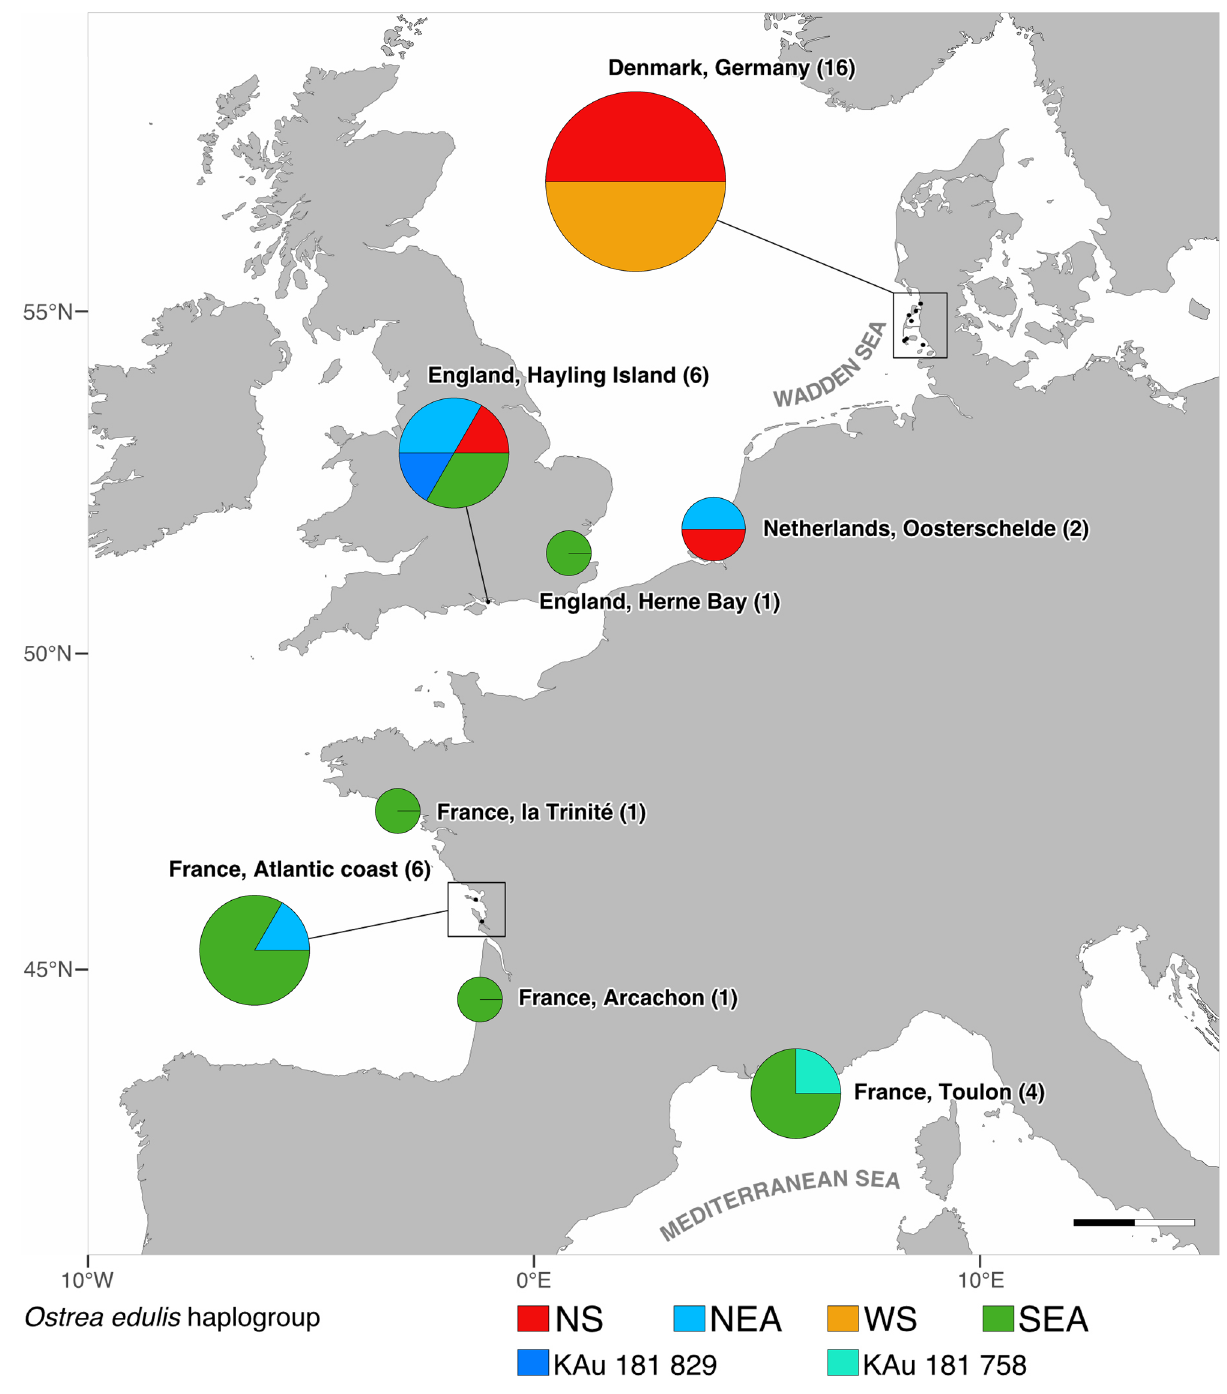
Figure 3. Geographic distribution of mitochondrial haplogroup frequencies of Ostrea edulis in Europe between 1869 and 1879. The smallest pie chart represents a single individual. All sample sizes are given in brackets on each location. Scale bar = 100 km. legend: NS = North Sea, NEA = North East Atlantic, WS = Wadden Sea, SEA = South East Atlantic. Map was created using R Studio version 1.1.453 (https ://rstud io.com) 39